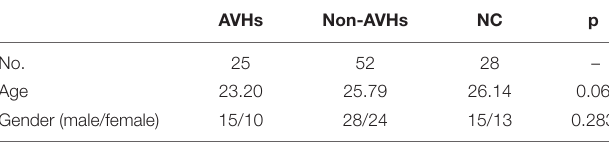
TABLE 1 | Demographic data of the three